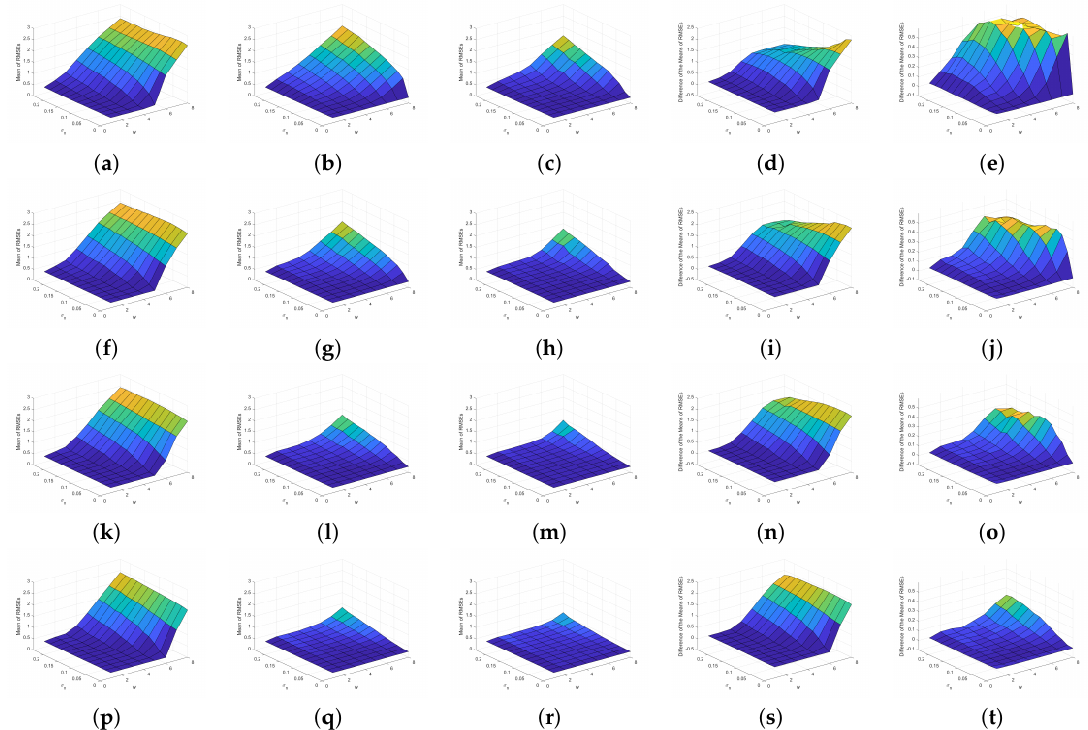
Figure 7. RMSE distribution effects for simulated line detection under varying line width ( w ), noise strength ( σ n ), and smoothing factor ( σ s ). (column 1) SD, (column 2) EC, and (column 3) SGAD-based line-detection methods; (column 4) difference between SD- and SGAD-based methods; and (column 5) difference between EC- and SGAD-based methods. ( a – e ) σ s = 0.5, ( f – j ) σ s = 0.75, ( k – o ) σ s = 1.0, and ( p – t ) σ s =